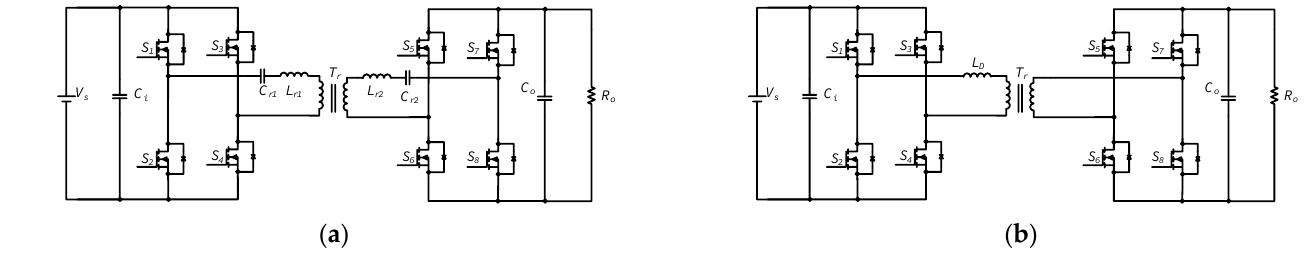
Figure 1. Bidirectional converters: ( a ) CLLC converter; ( b ) DAB converter. Similar to the CLLC converter, the DAB converter is one of the solutions to achieve ZVS by controlling the switching frequency and different phase-shift angle between the bridges with galvanic isolation [9–17]. At heavy load conditions, DAB converters often have higher conversion efficiency for high power applications. In [15], the DAB scheme is used for solid-state transformers and maintains the advantages of conventional DAB, and obtains the bidirectional fault-handling capability for DC distribution applications. In [17], the design of modulating the phase-shift ratios is analyzed to suppress reactive power and increase the efficiency under non-unity voltage gain conditions. Global opti- mal phase-shift signals that minimize the reactive power under four different DAB oper-